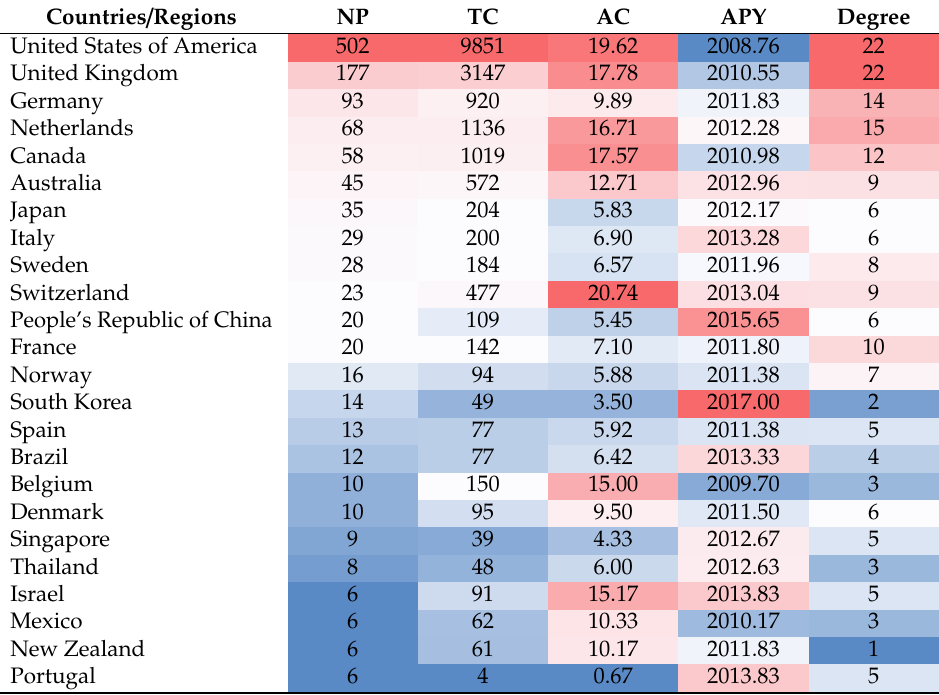
Table 3. High-productivity countries / regions in risk